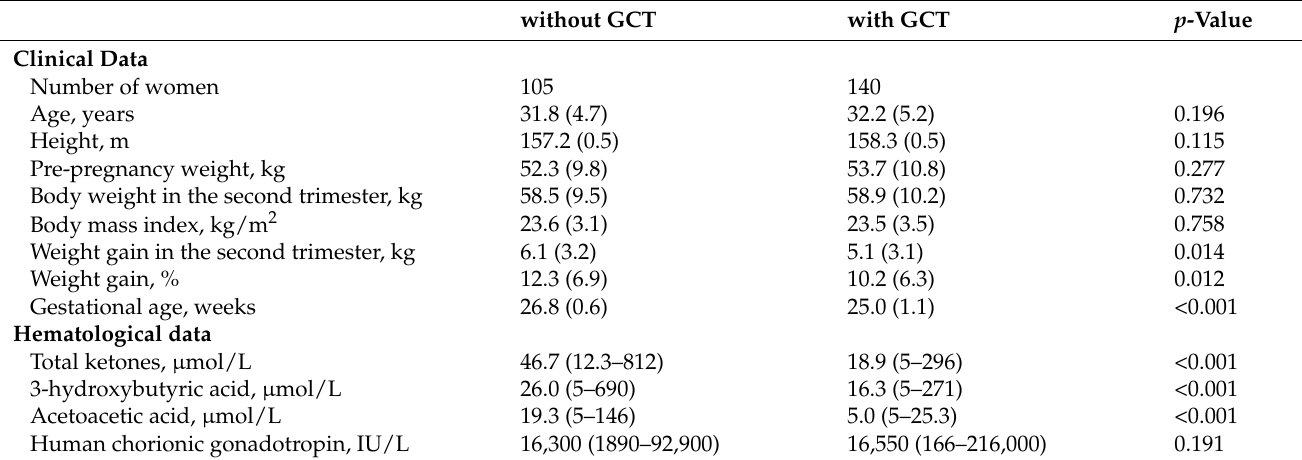
Table 3. Comparison of hematological parameters in the second trimester in the groups with and without a glucose challenge test. without GCT with GCT p -Value